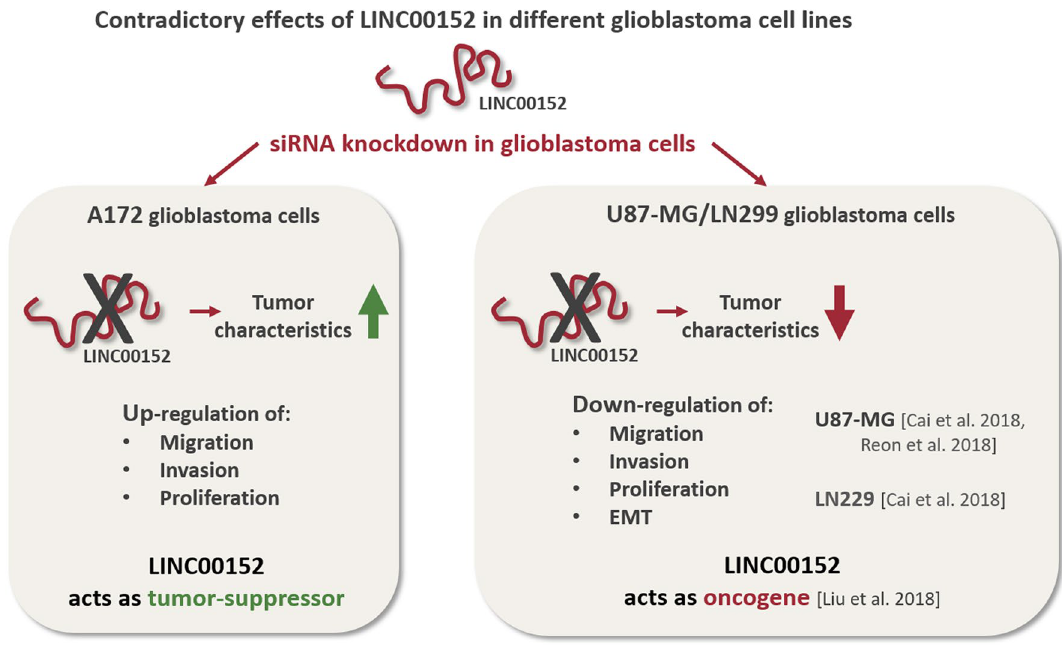
Figure 4. LINC00152 knockdown leads to contrary phenotypes in different glioblastoma cell lines. LINC00152 knockdown in U87-MG and LN229 glioblastoma cells has been shown to result in a decrease of cell migration, invasion, proliferation and EMT, indicating its oncogenic properties (right box). However, as we observed in A172 glioblastoma cells, LINC00152 seems to have opposing features (left